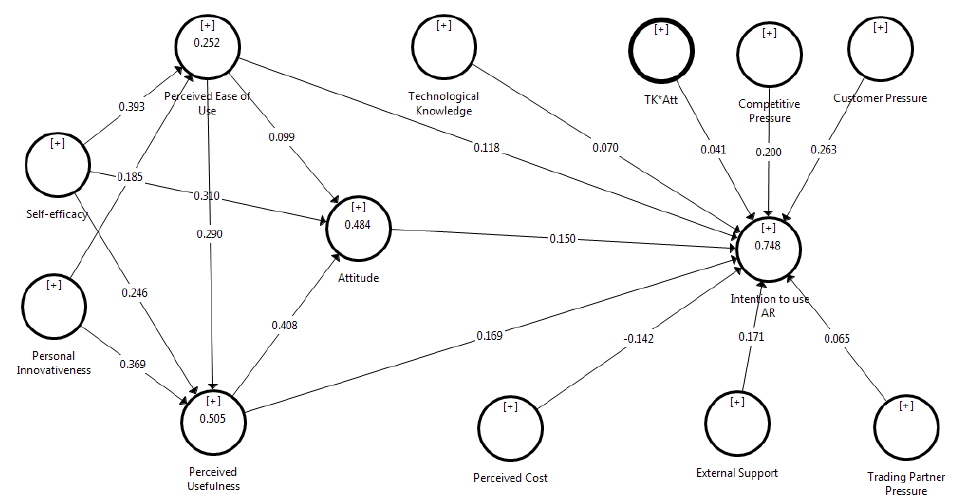
Figure 4. Moderation model.